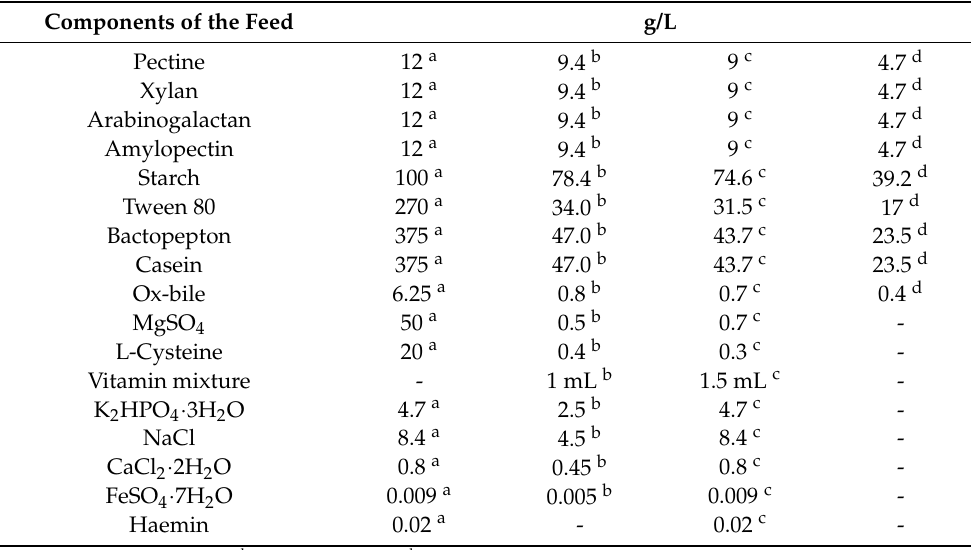
Table 2. Nutritional media composition of the SIEM in different